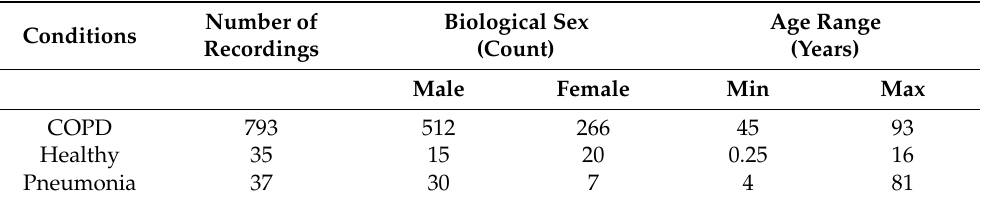
Table 1. ICBHI 2017 challenge database selected class